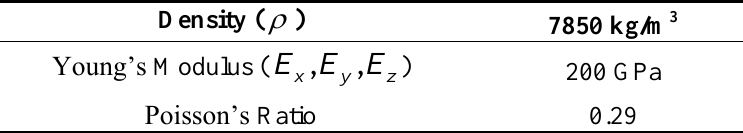
Table 1. Stainless steel AISI4340 specifications.